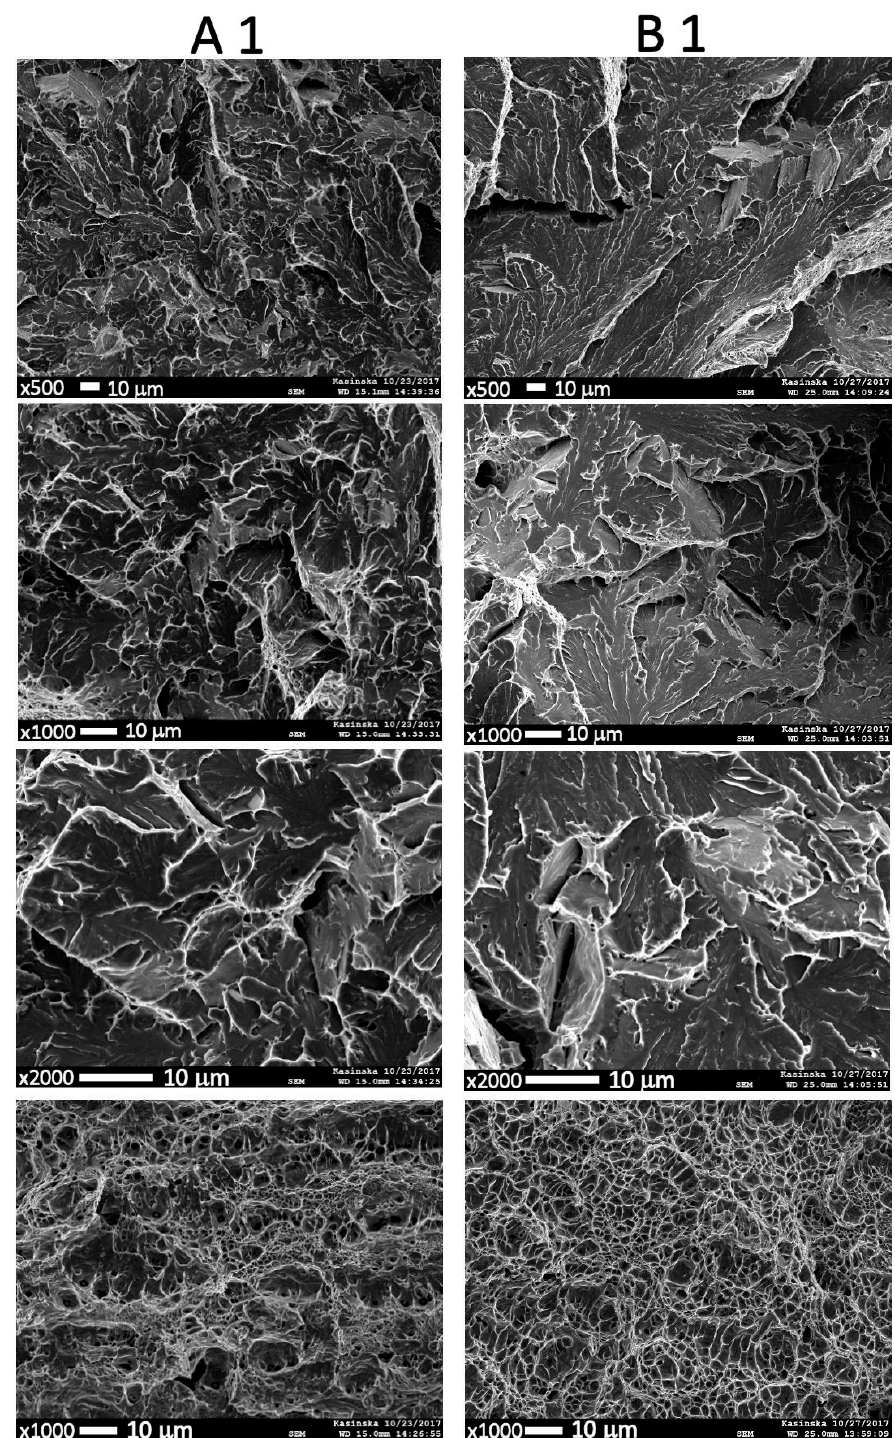
Figure 11. Morphology of A1 and B1 fracture surfaces.